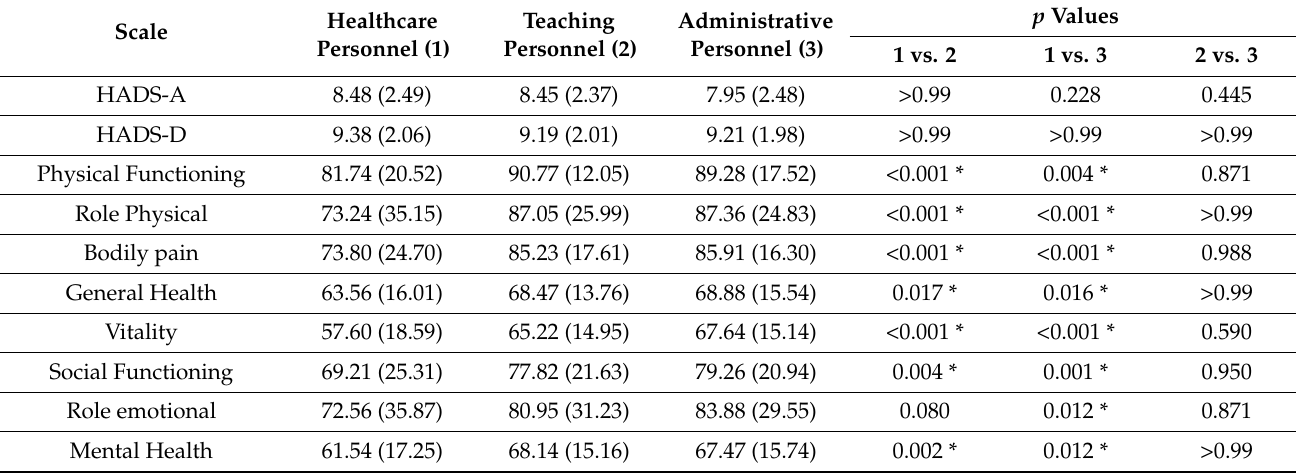
Table 3. Anxiety, depression and HRQoL scores (means and SD) by professional category and between-group comparisons.